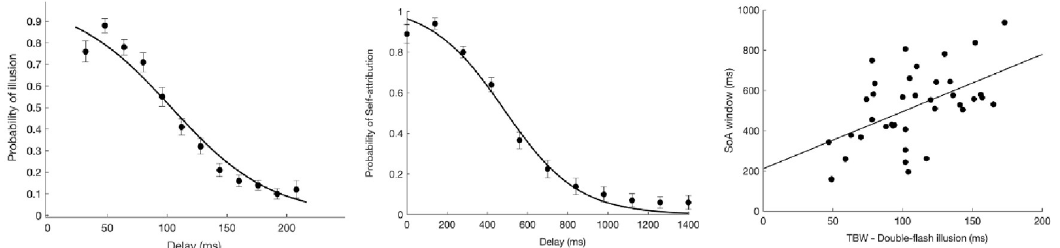
Fig 5. Relationship between TBW and SoA window. (A) Across-participants average probability of perceiving the illusion plotted as a function of inter-beep delay. The curve represents the sigmoid fit determining the amplitude of the window of illusion, corresponding to the inflection point of the sigmoid. The points represent across-participants average raw data with error bars showing standard error of the mean. (B) Across-participants average probability of self-attribution plotted as a function of the delay. The curve represents the sigmoid fit determining the amplitude of the SoA window corresponding to the inflection point of the sigmoid. The points represent across-participants average raw data with error bars showing standard error of the mean. (C) Linear correlation between TBW (double-flash illusion) and the SoA window (judgement of agency